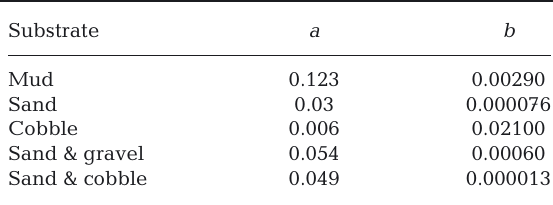
Table 3. Parameters for modelled fits (all R 2 = 0.99, p < 0.0001) of cumulative mass eroded versus shear stress (see Eq. 3) for the 5 different bottom substrates of the